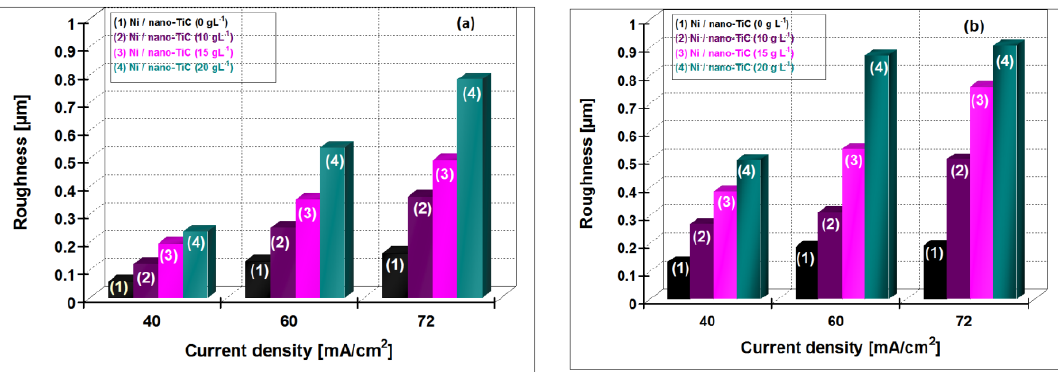
Figure 14. Roughness values as a result of 3D profiles for: Ni/nano-TiC (0 g · L −1 ) şi Ni/nano-TiC (10, 15, 20 g · L −1 ) produced under the same experimental conditions at deposition time of: ( a ) 15 min; ( b ) 30 min.